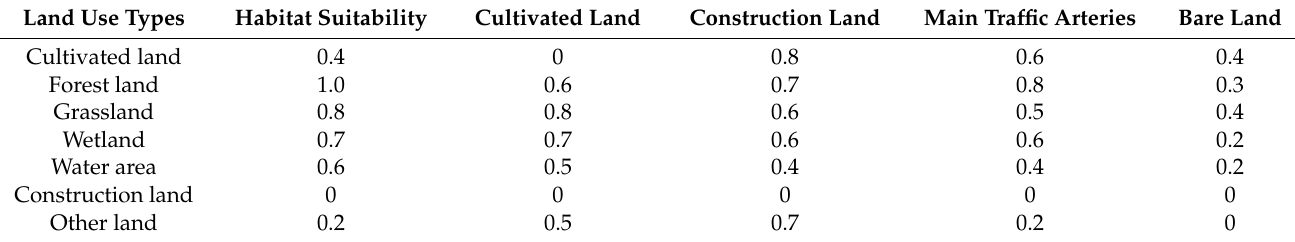
Table 2. Sensitivity of land use types to the threat